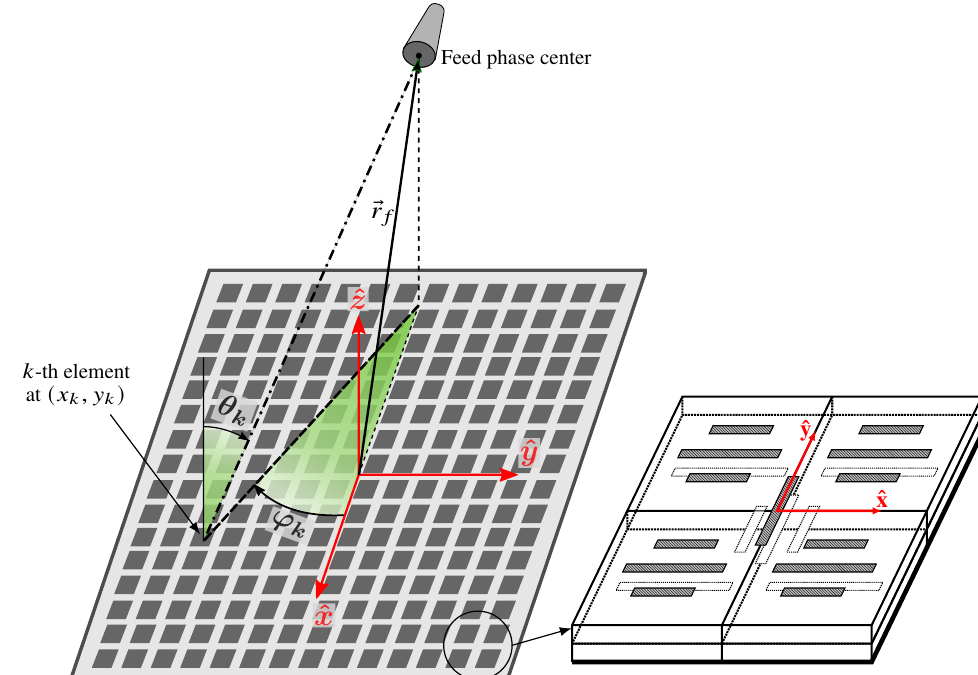
Figure 1. Sketch of the single-offset reflectarray configuration and unit cell employed in this work. The reflectarray is planar and composed of a number of reflective unit cells. The feed phase center is positioned at (cid:126) r f in the XZ plane. Each reflectarray element experiences a unique angle of incidence. In the example shown in this figure, the value of ϕ k is negative since y k < 0. Adapted from ref.